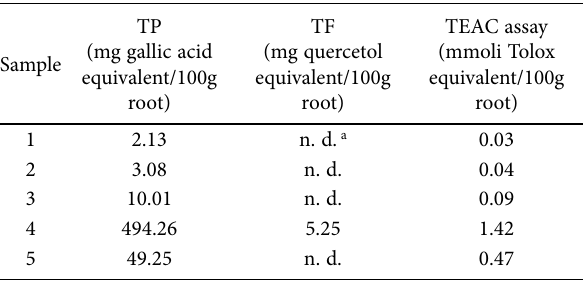
Table 1. TP, TF and TEAC assay for L. sibirica rhizome and root